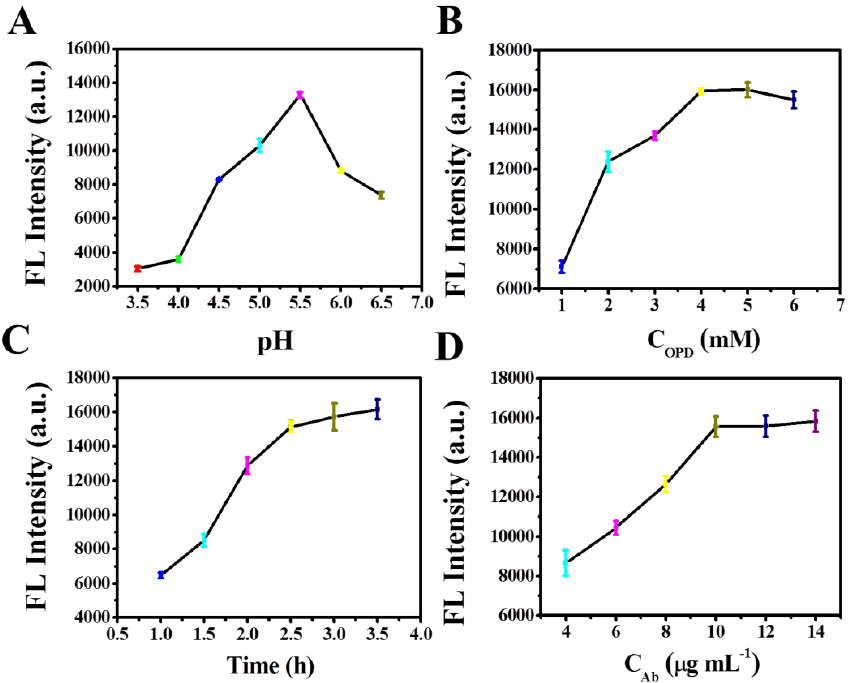
Figure 4. Effects of ( A ) pH of CP/ZIF-8/PDA reaction with OPD, ( B ) OPD concentration, ( C ) incubation time of OPD and ( D ) Ab concentration on the fluorescence intensity. A total of 2 mmol L −1 of OPD was used for pH optimization, 4 mmol L −1 of OPD was used for other optimization, and 5 ng mL −1 of CEA was used.